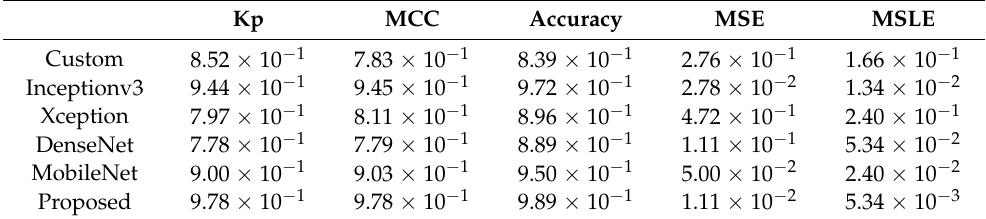
Table 5. The classification report for each of the models and the final model using the PCB dataset. Kp MCC MSE